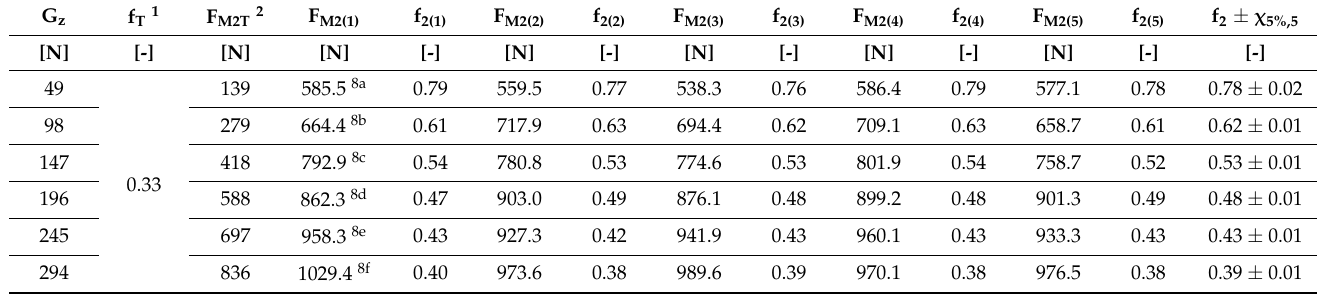
Table 8. Tensile force F M2(i) [N] , φ 8 mm rope, V-shaped groove, dihedral angle 35 deg, clean condition.